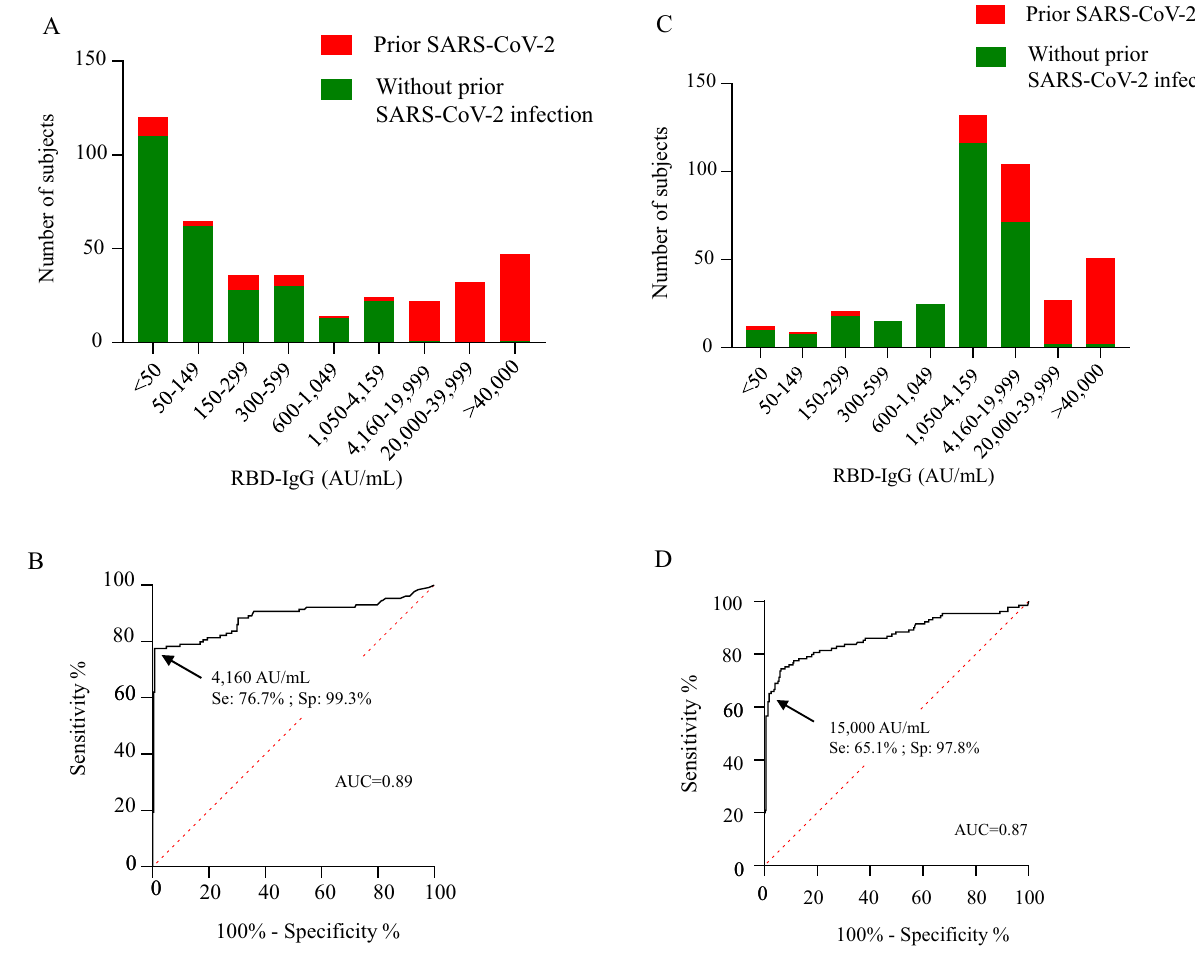
Figure 2. RBD-IgG levels among participants with or without prior SARS-CoV-2 infection. ( A ) Distribution of RBD-IgG levels in the entire population of participants 3 weeks after the first dose. ( B ) ROC evaluating the performance of RBD-IgG levels after the first dose, as a marker of prior SARS-CoV-2 infection; RBD-IgG > 4160 AU/mL: PPV: 98.0%; NPV: 89.8%; sensitivity: 76.7%; specificity 99.3%. ( D ) Distribution of RBD-IgG levels in the entire population of participants 6 weeks after the first dose. ( C ) ROC evaluating the performance of RBD- IgG levels after the second dose, as a marker of prior SARS-CoV-2 infection; RBD-IgG > 15,000 AU/mL: PPV: 93.3%; NPV: 85.3%; sensitivity: 65.1%; specificity: